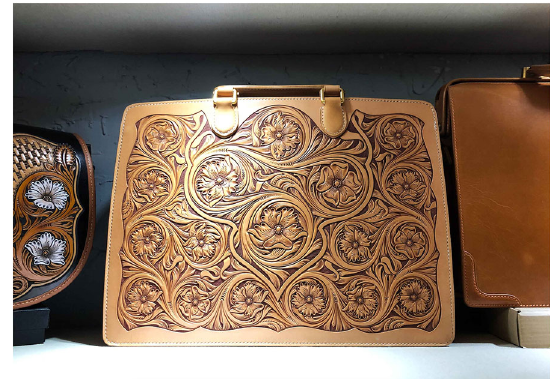
Fig. 4 Leather hand bag with intricate carving (authors